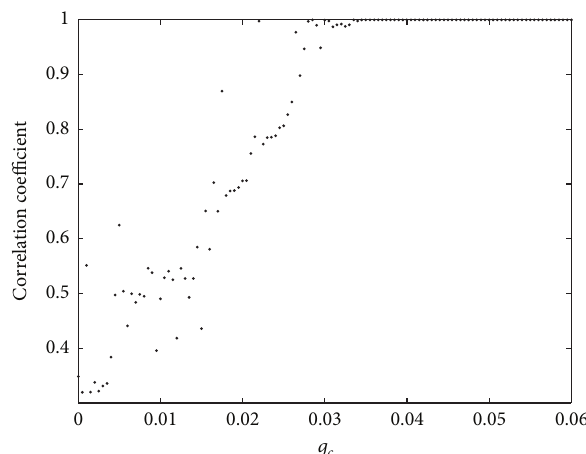
Figure 5: Plot of correlation coefficient of two coupled neurons as a function of coupling strength 𝑔 𝑐 .